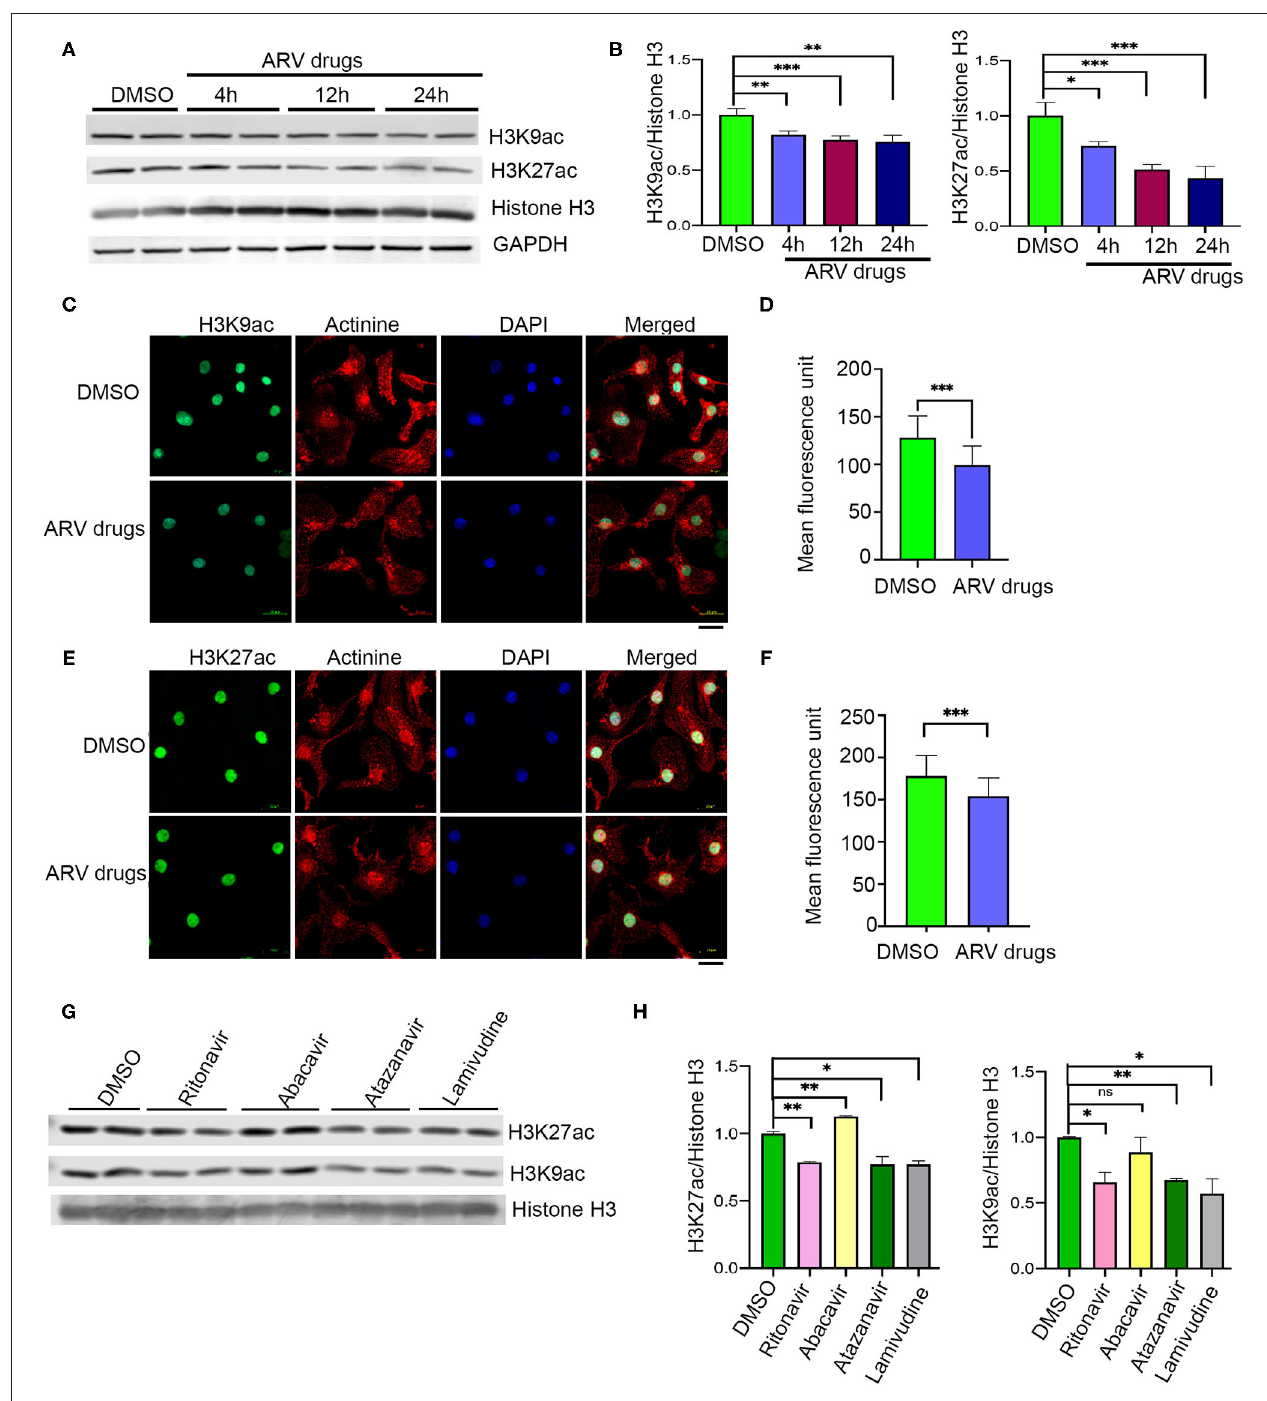
FIGURE 1 | ARV drugs treatment suppresses active histone marks. (A,B) Western blots show acetylation of histone at H3K9 and H3K27 and graphs show its quantification (*** p < 0.001). NRVCs were treated with ARV drugs (5 µ M of Ritonavir, Abacavir, Atazanavir and Lamivudine) for 4, 12, and 24h and western blots were done with total protein lysate. (C,D) Representative images show immunofluorescence staining of NRVCs stained with H3K9ac (green), actinin (red), and nucleus stained with DAPI (blue). Cells were treated with ARV drugs for 12h and fixed with 4% PFA. (D) Graph shows quantification of microscopic images ( n = 50 cells); (* p < 0.05). (E,F) Representative images show immunofluorescence staining of NRVCs stained with H3K27ac (green), actinin (red), and nucleus stained with DAPI (blue). Cells were treated with ARV drugs for 12h and fixed with 4% PFA. (D) Graph shows quantification of microscopic images ( n = 50 cells); (* p < 0.05). (G,H) Western blot shows acetylation of NRVCs after drugs treatment. NRVCs were treated with individual ARV drug for 12h and western blot was done with total protein lysate. Graphs show quantification of western blot (*** p < 0.001; ** p < 0.01, ns, not significant).